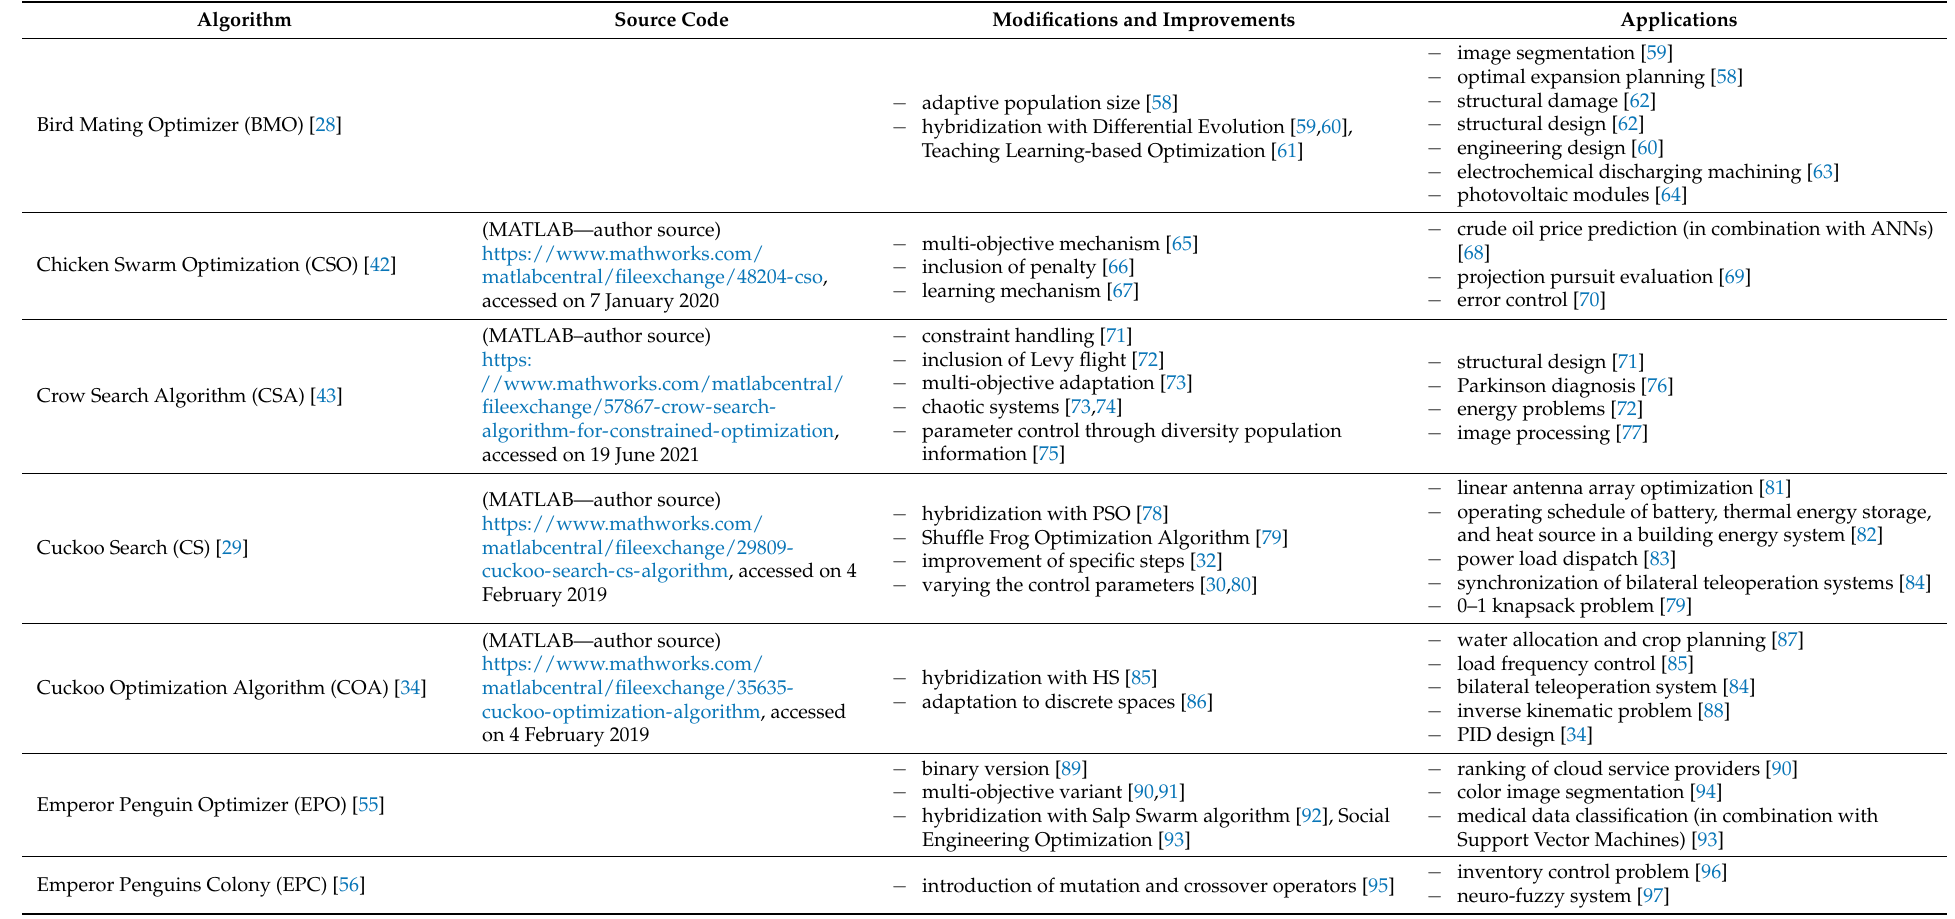
Table 1. Improvements and applications for bird-inspired metaheuristics (alphabetically